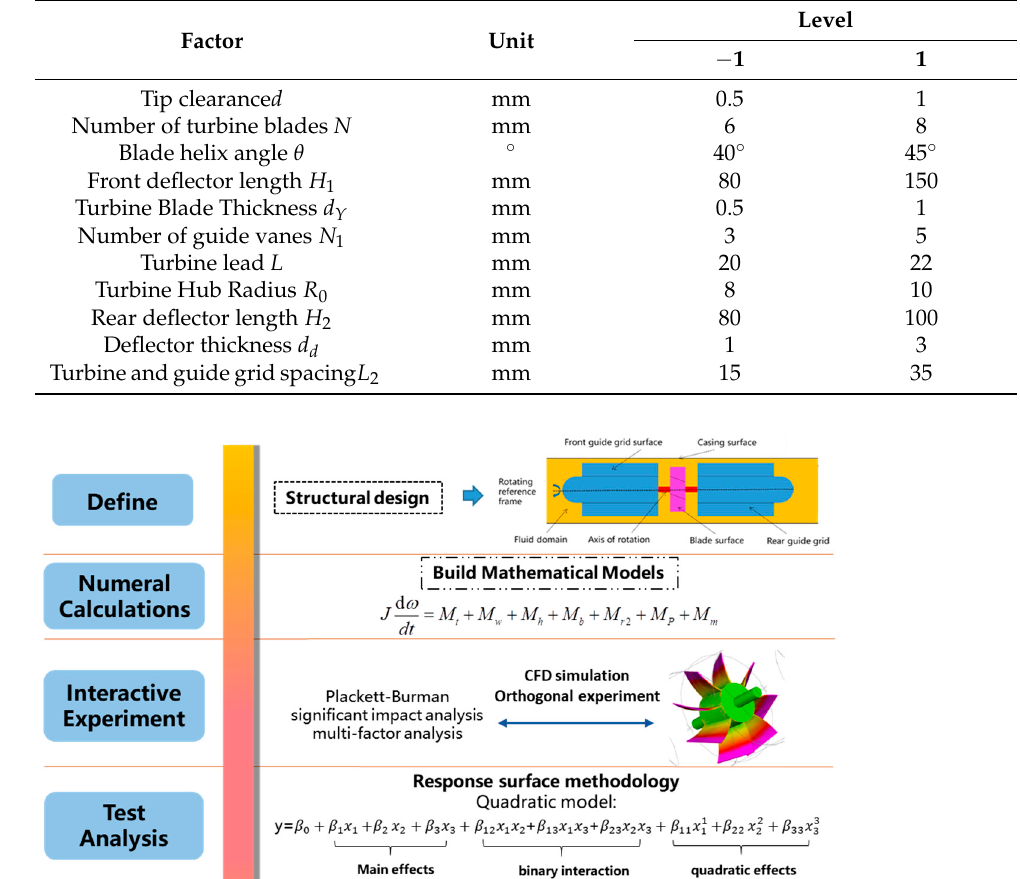
Table 1. Influencing factors and horizontal parameter values.